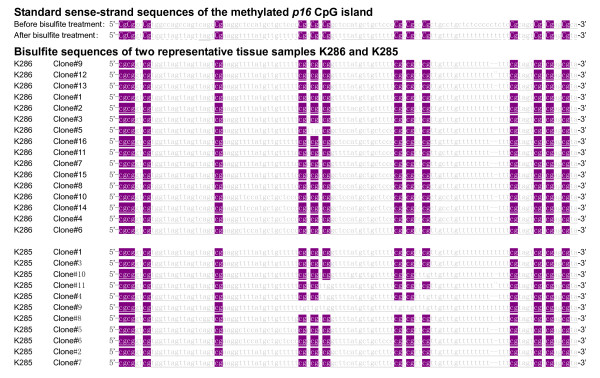
Results of clone sequencing of the 115-bp MethyLight PCR products. The sense-strand sequences of the methylated p16 CpG island with and without bisulfite treatment were listed. The bisulfite-treated template of two 115-bp MethyLight-positive samples was amplified with the same primer set. The PCR products of these two representative samples were clone-sequenced, respectively. 99.6% (223/224) and 93.5% (144/154) cytosines at CpG sites within total 16 and 11 clones (14 CpG sites/clone) from the sample K286 and K285 were maintained and 77.8% (548/704) and 90.9% (440/484) cytosines at non-CpG sites within these clones (44 non-CpG sites/clone) were converted to thymines, respectively. These results indicate that these clones are fully methylated at all CpG sites.